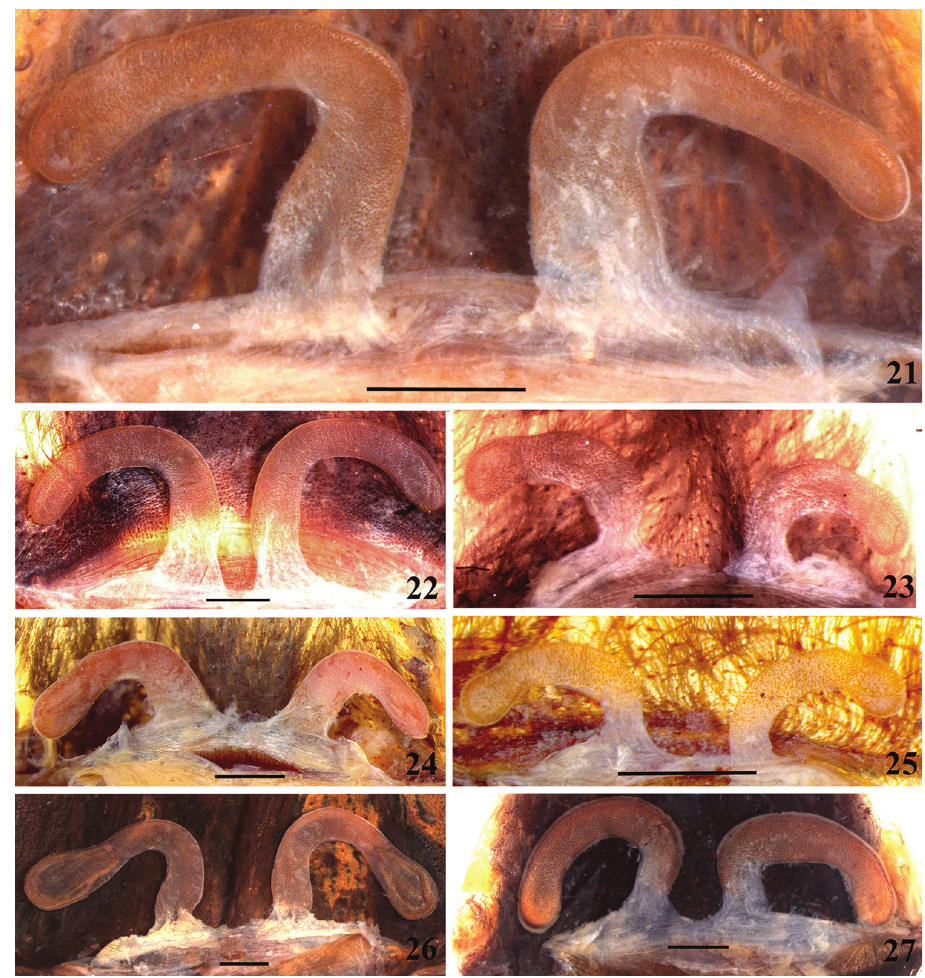
Figures 21–27. Avicularia avicularia (Linnaeus, 1758), spermathecae variation. 21 morphotype 1, Al- tamira, state of Pará, Brazil (MNRJ 13995) 22 morphotype 2, UHE Tucuruí, state of Pará, Brazil (IBSP 4885) 23 morphotype 3, Puerto Cabello, state of Carabobo, Venezuela (MNHN–AR 4883) 24 morpho- type 4, Cuenca Rio Los Amigos, department of Madre de Dios, Peru (UA 0042/2006) 25 morphotype 5, Yucumo, department of Beni, Bolivia (MNRJ 06919) 26 morphotype 6, Paramaribo, district of Para- maribo, Suriname (AMNH Su59) 27 morphotype 7, Juruti, state of Pará, Brazil (MPEG 15640). Scale bars = 1 mm.